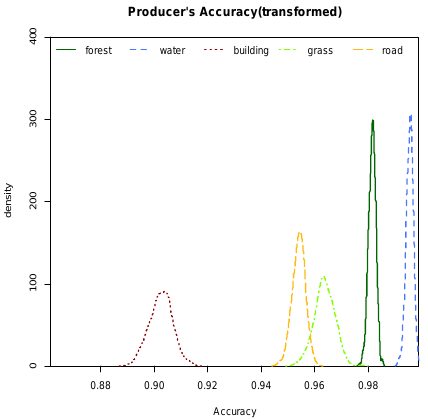
Figure 5. Distribution of producer’s accuracy with five classes